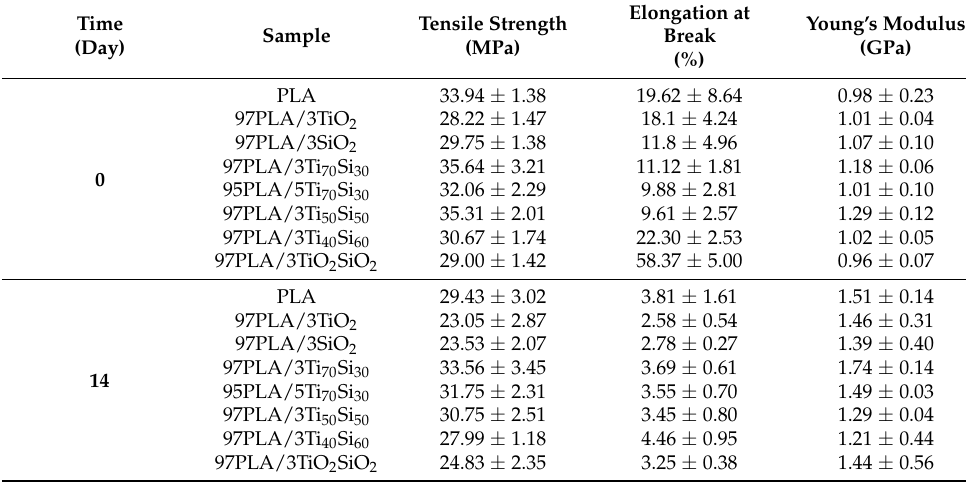
Figure 11. Weight loss of PLA, PLA/TiO 2 , PLA/SiO 2 , PLA/Ti x Si y , and PLA/TiO 2 SiO 2 composites films after different periods of in vitro degradation. Table 5. Tensile properties of properties of PLA, PLA/TiO 2 , PLA/SiO 2 , and PLA/Ti x Si y composite films after different period of in vitro degradation.